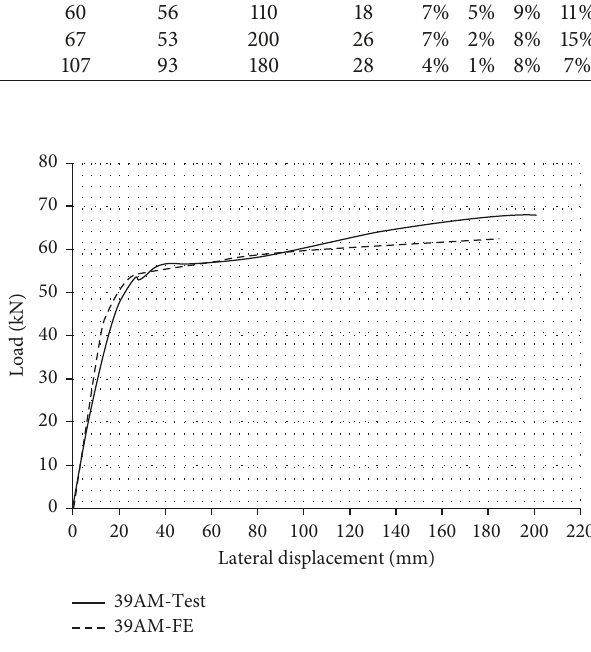
Figure 6: Load-deflection verification curve of test versus FE (specimen 9C).